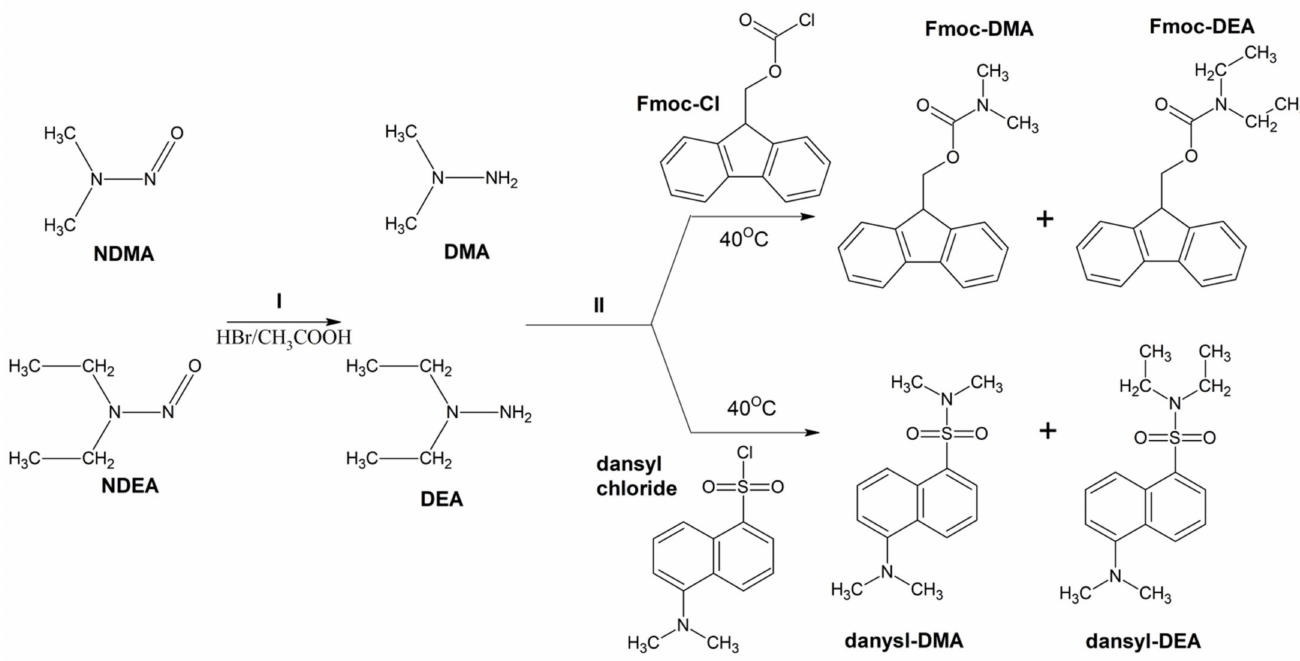
Figure 2. The denitrosation (I) and derivatisation (II) processes of NDMA and